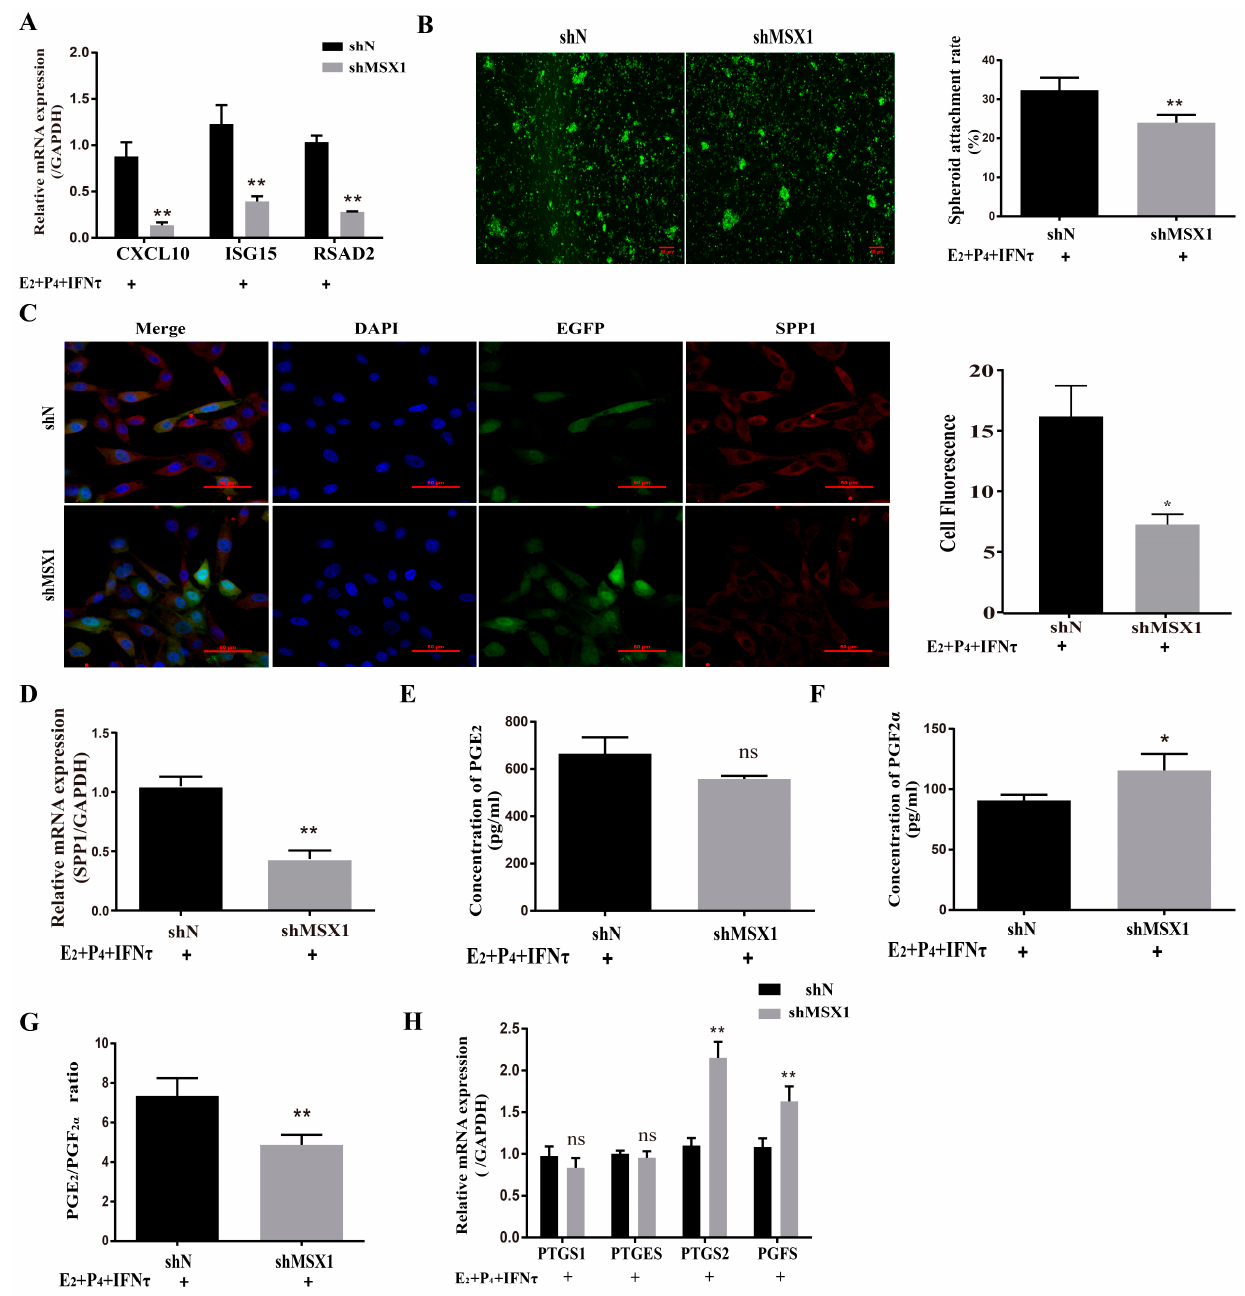
Figure 3. Knockdown of MSX1 affected endometrial adhesion and secretory function. ( A ) mRNA expression level of uterine receptivity markers ( ISG15, CXCL10, and RSAD2 ) in the shN group and shMSX1 group; ( B ) representative images and analysis of GTC spheroids in the shN group and shMSX1 group, scale bar = 50 µ m; ( C ) representative images and analysis of SPP1 expression in the shN group and shMsx1 group, scale bar = 50 μ m; ( D ) mRNA expression level of SPP1 in the shN group and shMSX1 group; ( E , F ) secretion of PGE 2 and PGF 2 α in the shN group and shMSX1 group; ( G ) ratio of PGE 2 /PGF 2 α in the shN group and shMSX1 group; ( H ) mRNA expression level of the PGs synthesis genes in the shN group and shMSX1 group. ns: p > 0.05; * p < 0.05; ** p < 0.01.